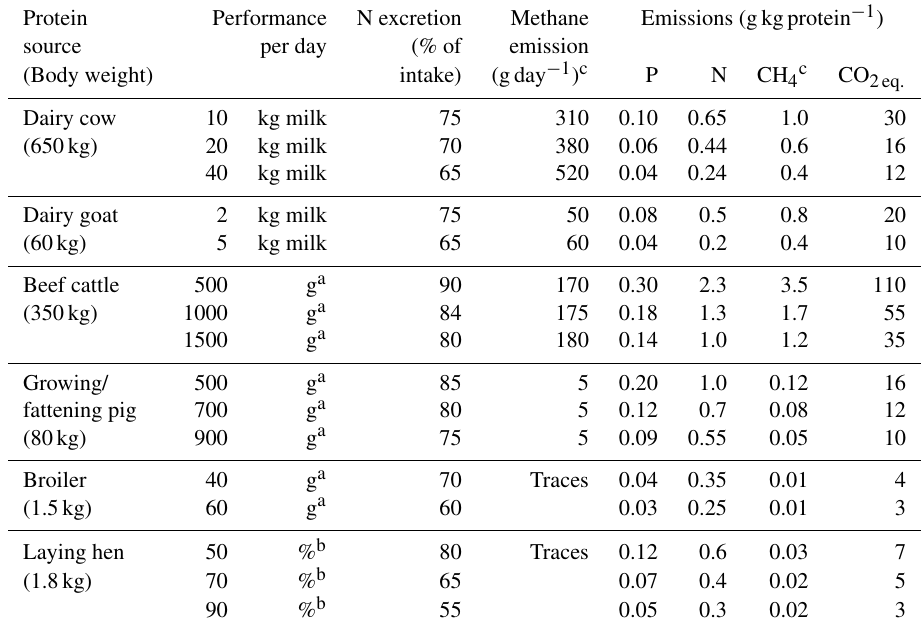
Table 15. Influence of animal species, categories and performances on emissions and footprints (per kilogram of edible protein; own calcu- lations based on data from Flachowsky and Kamphues, 2012).